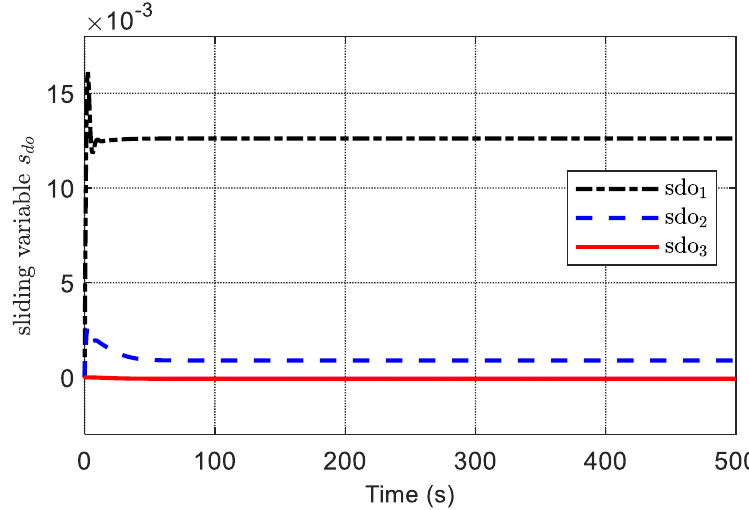
Figure 24. The sliding surface of the ADO.